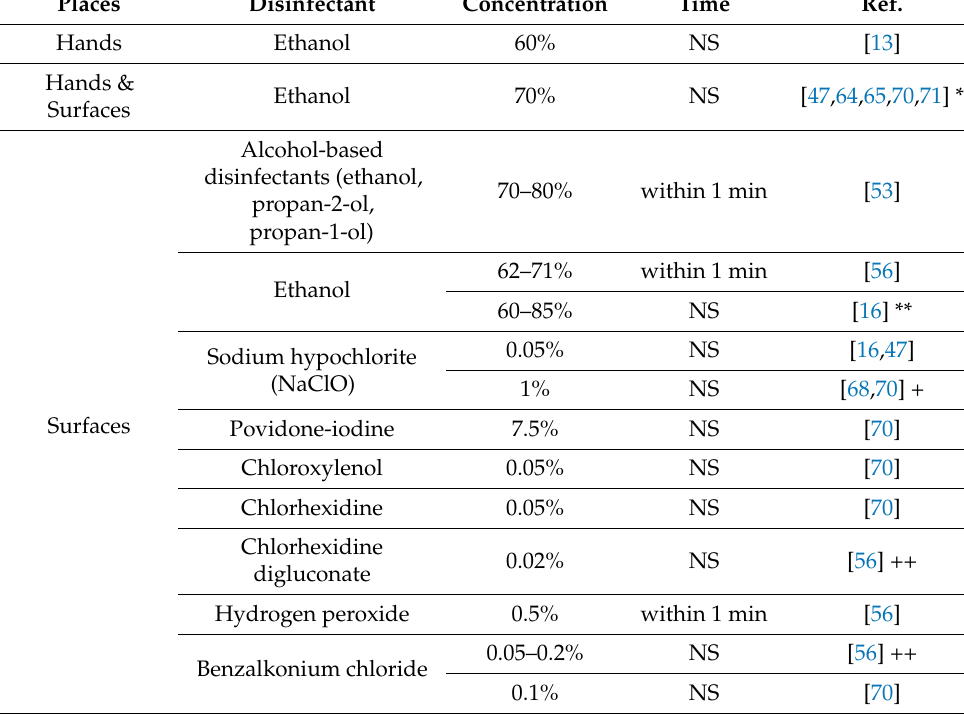
Table 2. Disinfectants that are the most recommended for hands, surfaces, and textiles to prevent, control, and mitigate